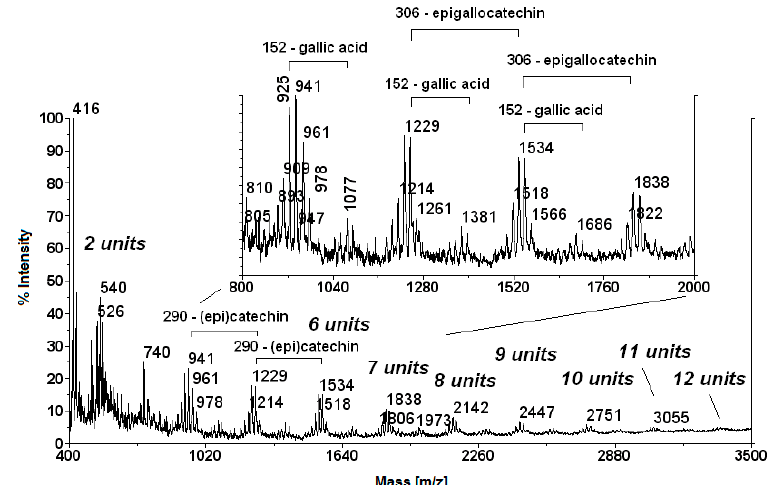
Figure 2. MALDI-TOF MS spectrum of the chestnut peel extract acquired in the linear ion mode. Up to 12 condensed monomeric units were detected. A shift of 1–2 units in the measurement of the MW are within the ordinary experimental error of the linear mode MALDI-TOF MS analysis.